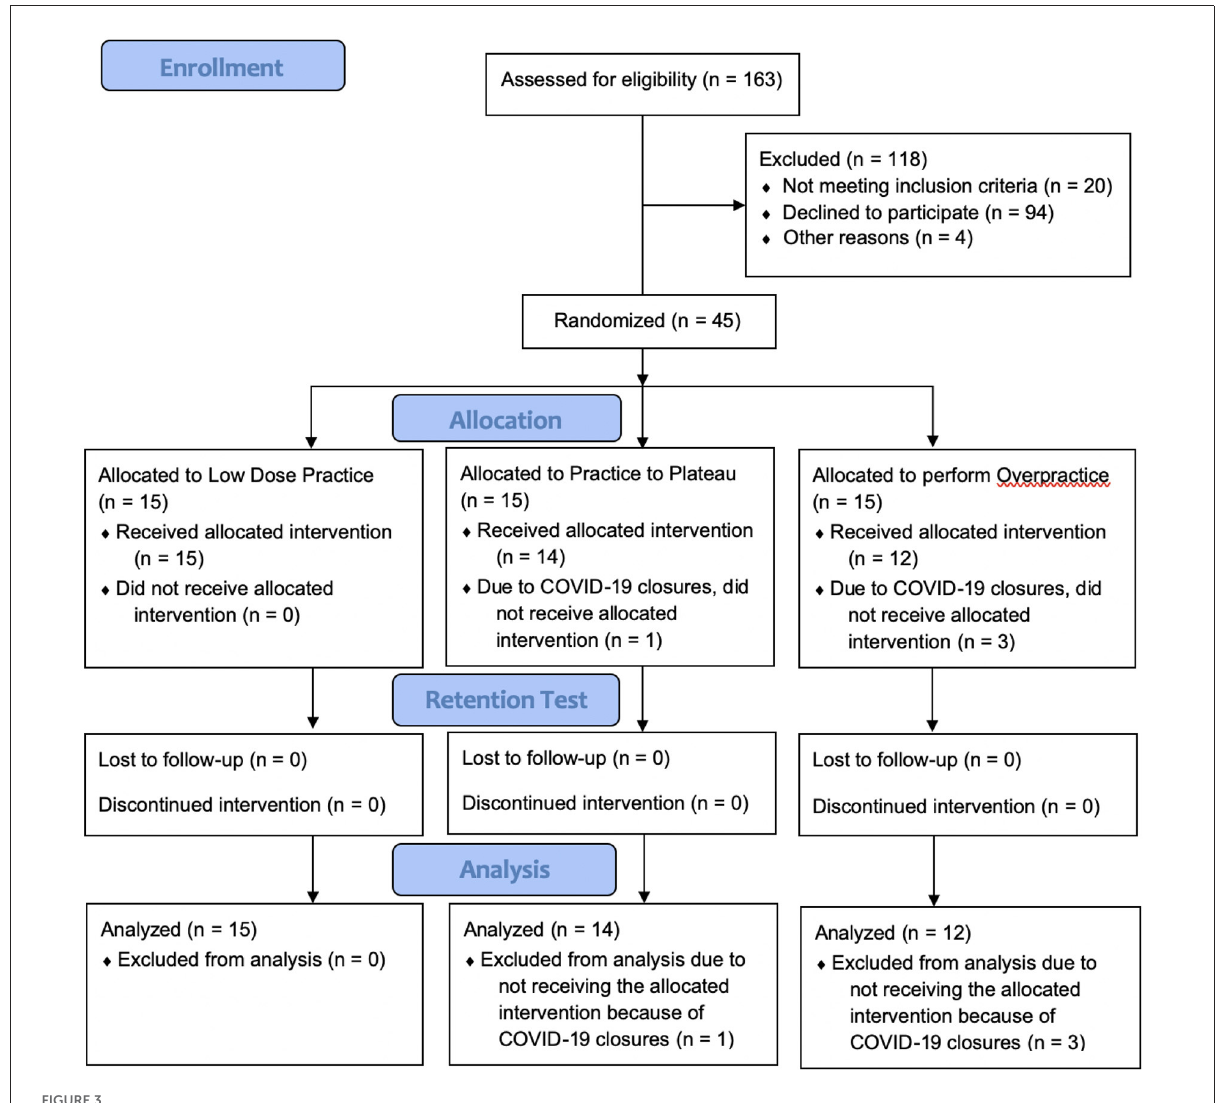
FIGURE3 Participant flow through the pilot randomized controlled